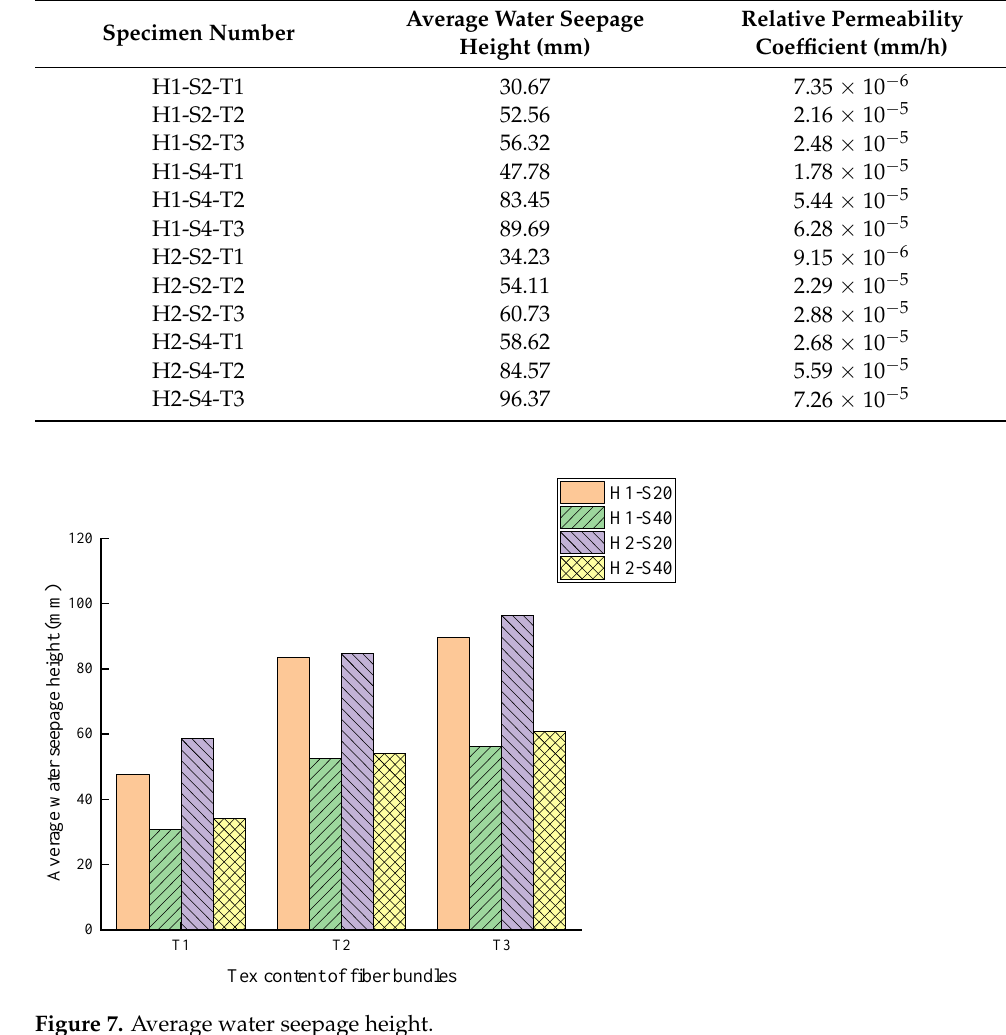
Table 5. Permeability test results.